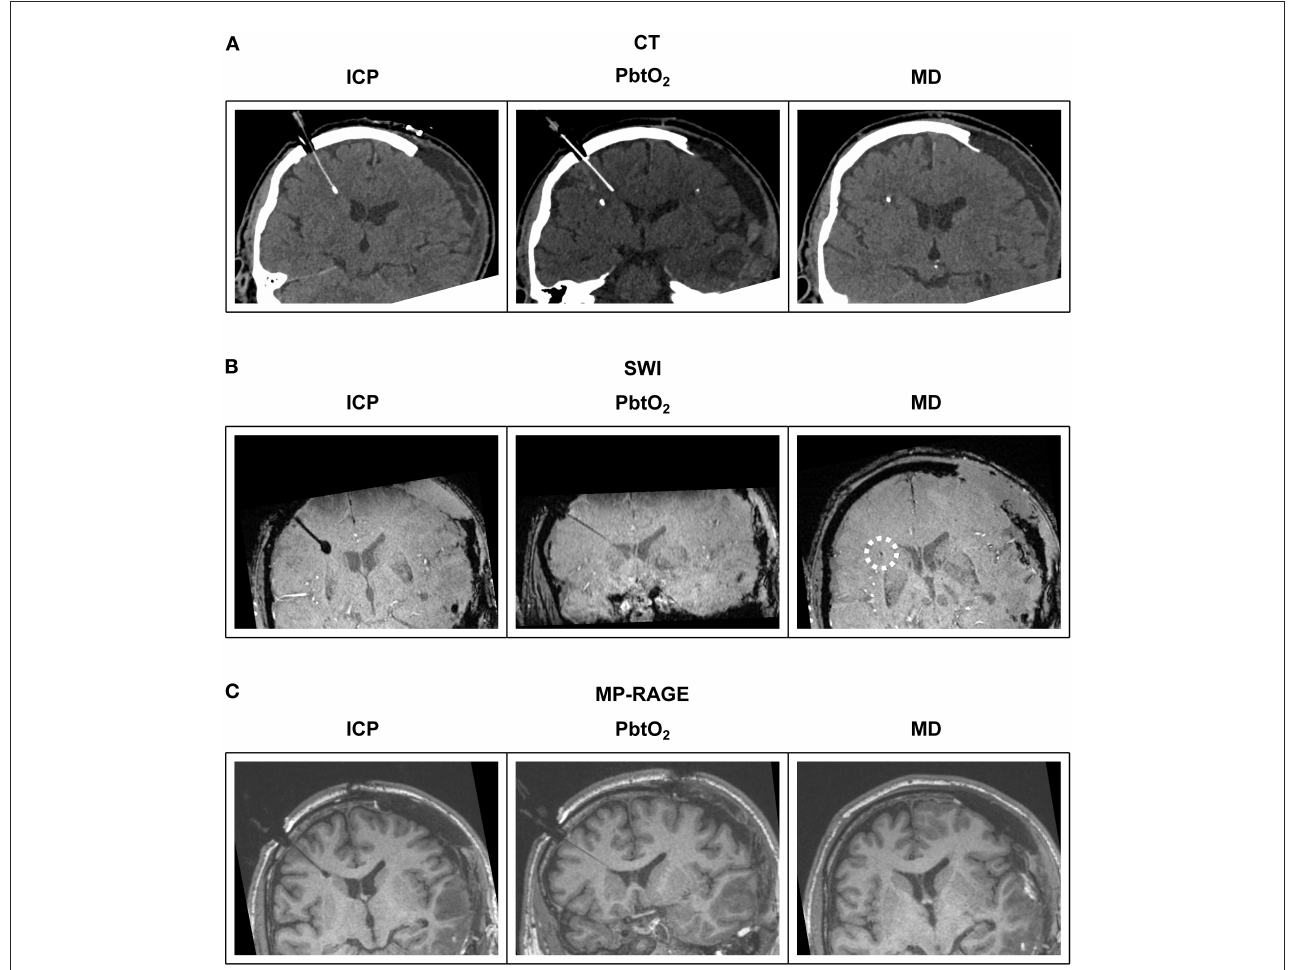
FIGURE2 Illustrative examples of multimodal monitoring appearance on CT and MRI. Reformatted coronal slices demonstrate ICP, PbtO 2 and microdialysis probes in a patient’s brain. (A) CT; The ICP probe’s thin shaft and bulbous end can be distinguished from the PbtO 2 probe’s uniform shaft and tip. Only the gold filament at the end of the microdialysis catheter is visible. (B) MRI T2-weighted SWI sequence; The same bulbous tip of the ICP probe and uniform thickness PbtO 2 probe is revealed as with CT. The gold tipped microdialysis catheter is just visible on SWI sequences (highlighted by white dashed